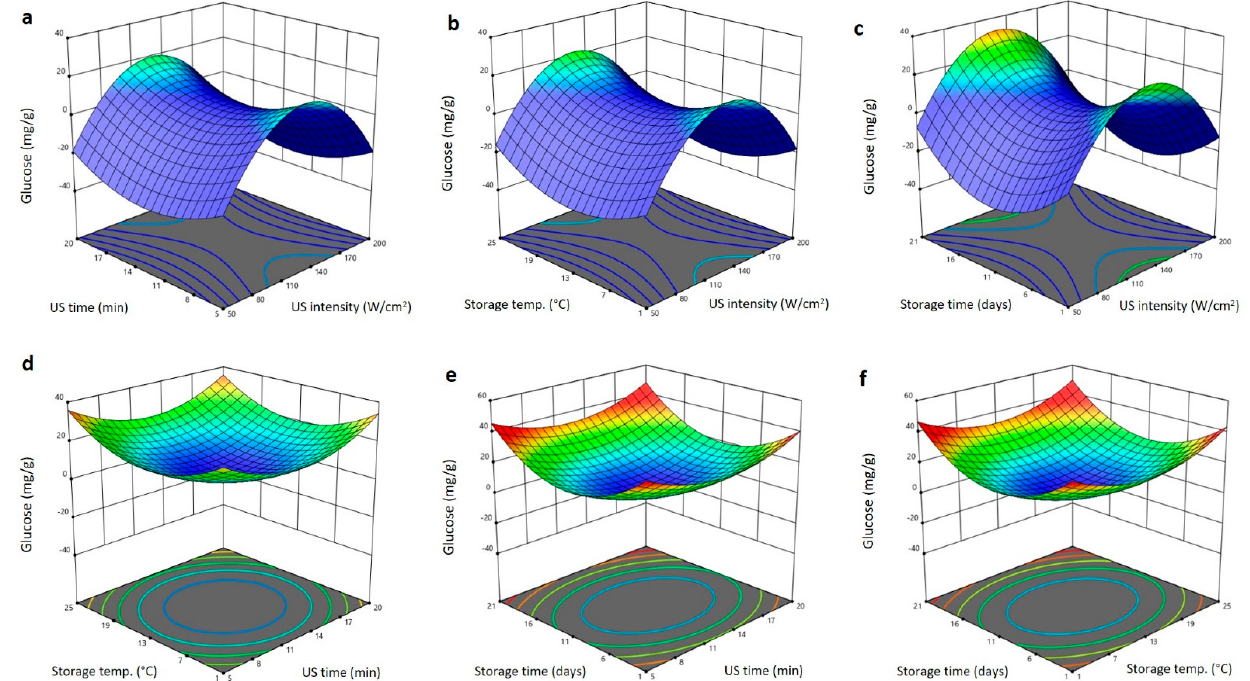
Figure 8. Response surface plots of glucose content of Barhi dates as a function of US time and US intensity ( a ), storage temperature and US intensity ( b ), storage time and US intensity ( c ), storage temperature and US time ( d ), storage time and US time ( e ), and storage time and storage temperature ( f ).